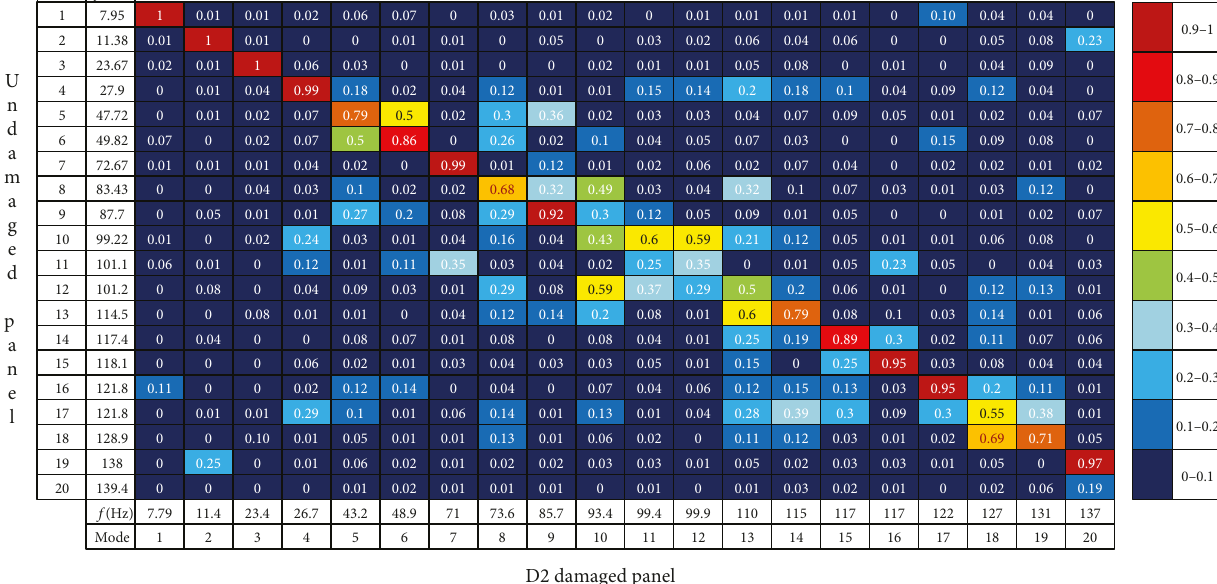
Figure 14: Undamaged panel – D2 damaged panel MAC.